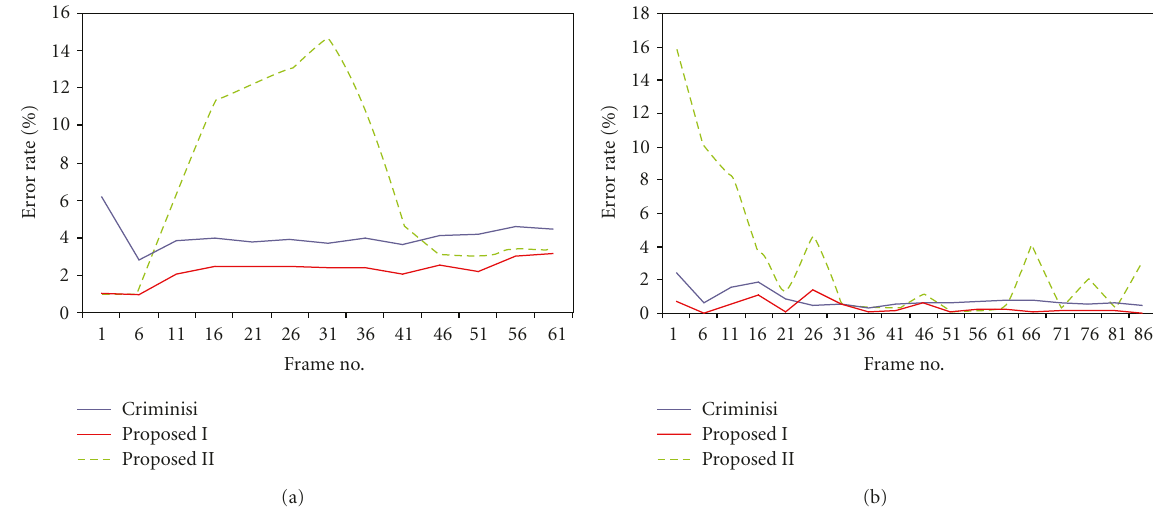
Figure 17: Comparison of the error rates on the (a) “Tiger” and (b) “Man in blue”